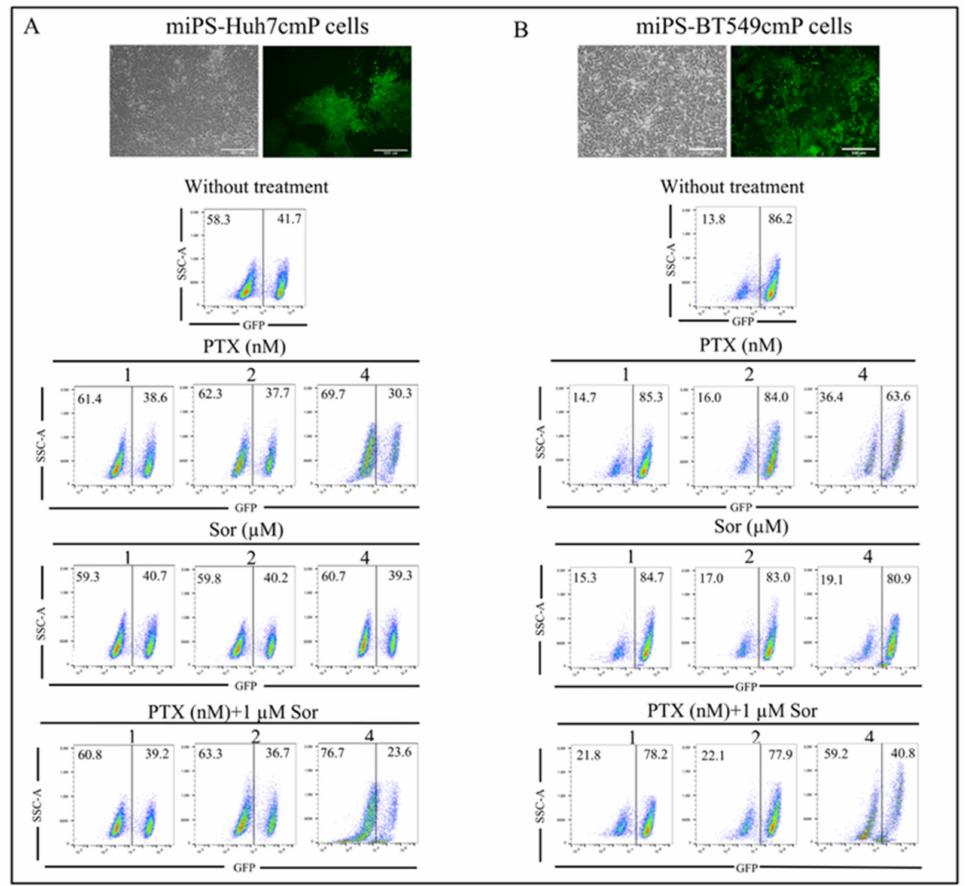
Figure 3. Combined treatment reduced the green fluorescent protein GFP more than monotherapies. Flow cytometry analysis of GFP expressing cells for miPS-Huh7cmP ( A ) and miPS-BT549cmP cells ( B ). Each result is shown as a representative of at least three independent experiments ( n =